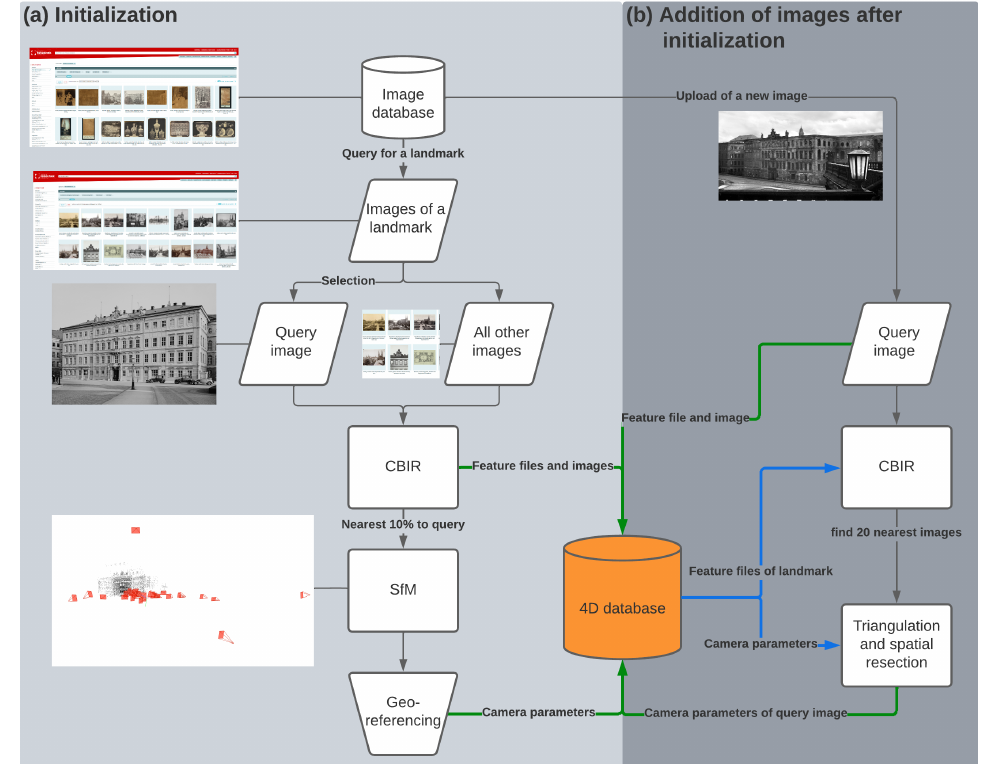
Figure 2. Schematic depiction of the presented bipartite pipeline for estimation of camera orientation parameters of historical photographs. The left hand shows the initialization of a new dataset, including the automatic selection of appropriate images using CBIR, subsequent SfM processing, and interactive georeferencing. The right hand shows the usage of the initialized data for estimating the camera orientation parameters for newly digitized images. The 4D database serves as a central part of storing and distributing all relevant